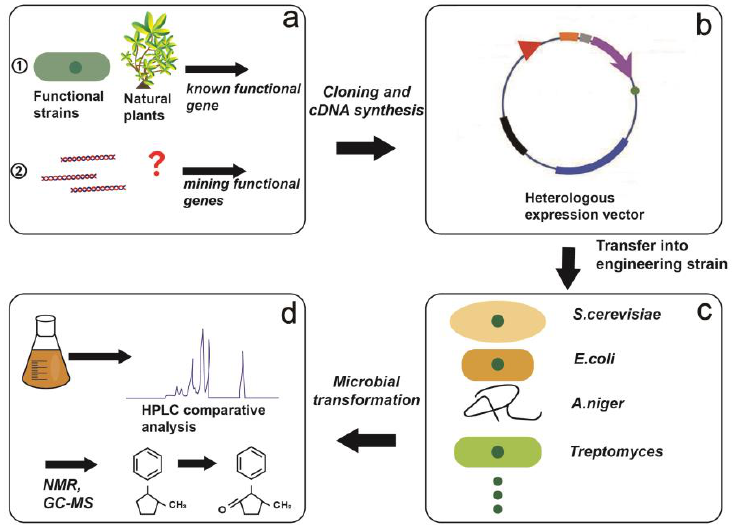
Figure 3. Basic steps of heterologous biosynthesis. ( a ) ① Select known functional genes from plants and strains. ② Screen the unknown functional genes of the strain through the analysis of genome and transcriptome, and then select the homologous genes of other strains in NCBI, and then select the highly expressed functional genes through the level of transcription and transformation products. ( b ) Clone and synthesize cDNA, then select the appropriate vector and construct. ( c ) Transform the recombinant plasmid into the engineering strain. ( d ) Use the engineering strain to ferment the target substrate, HPLC comparative analysis to detect the transformation ability, and then analyze the structure of the transformation product by NMR and GC-MS.